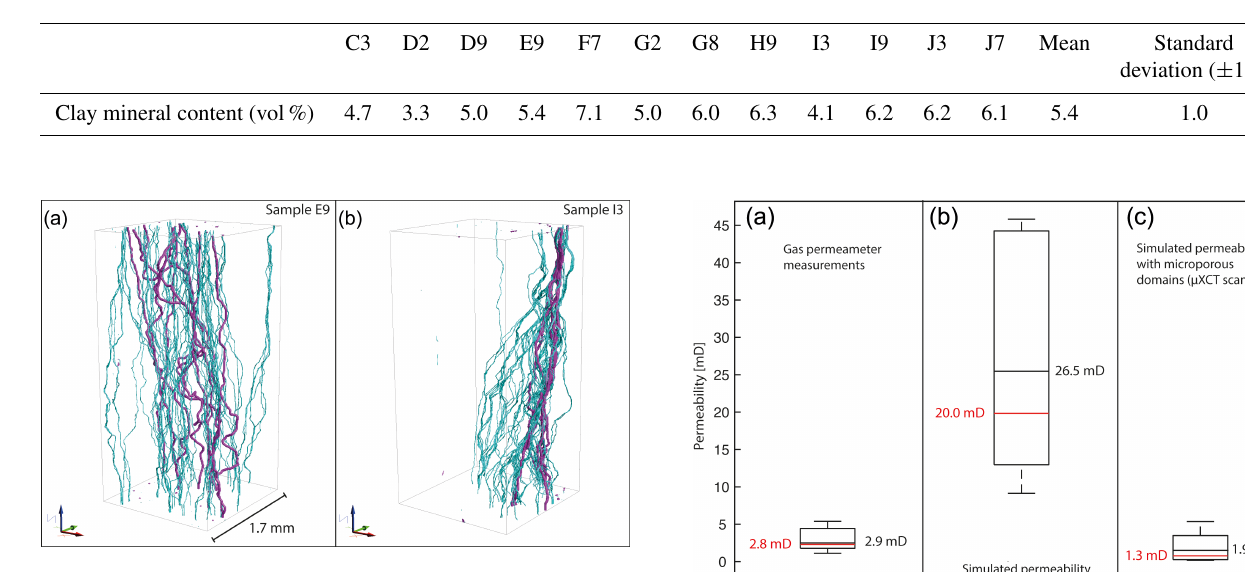
Table 3. Modelled clay mineral content within the microporous domains in µXCT scans.